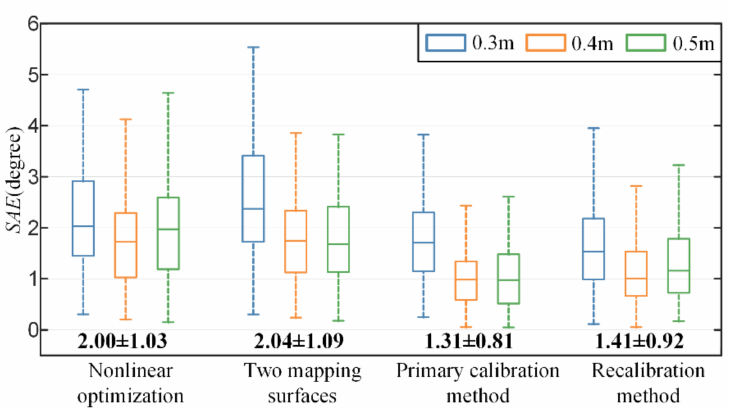
Figure 9. Comparison of the proposed method and state-of-the-art methods at different depths. The bold numbers at the bottom are the angular error in degrees (mean ± standard